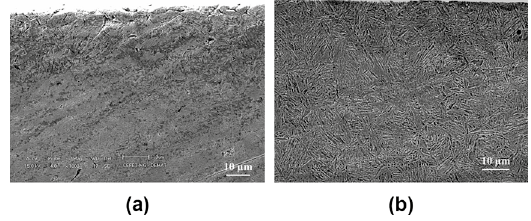
Figure 3. Micrographs of the not grinded sample (A) and grinded with Mineral Oil (B).